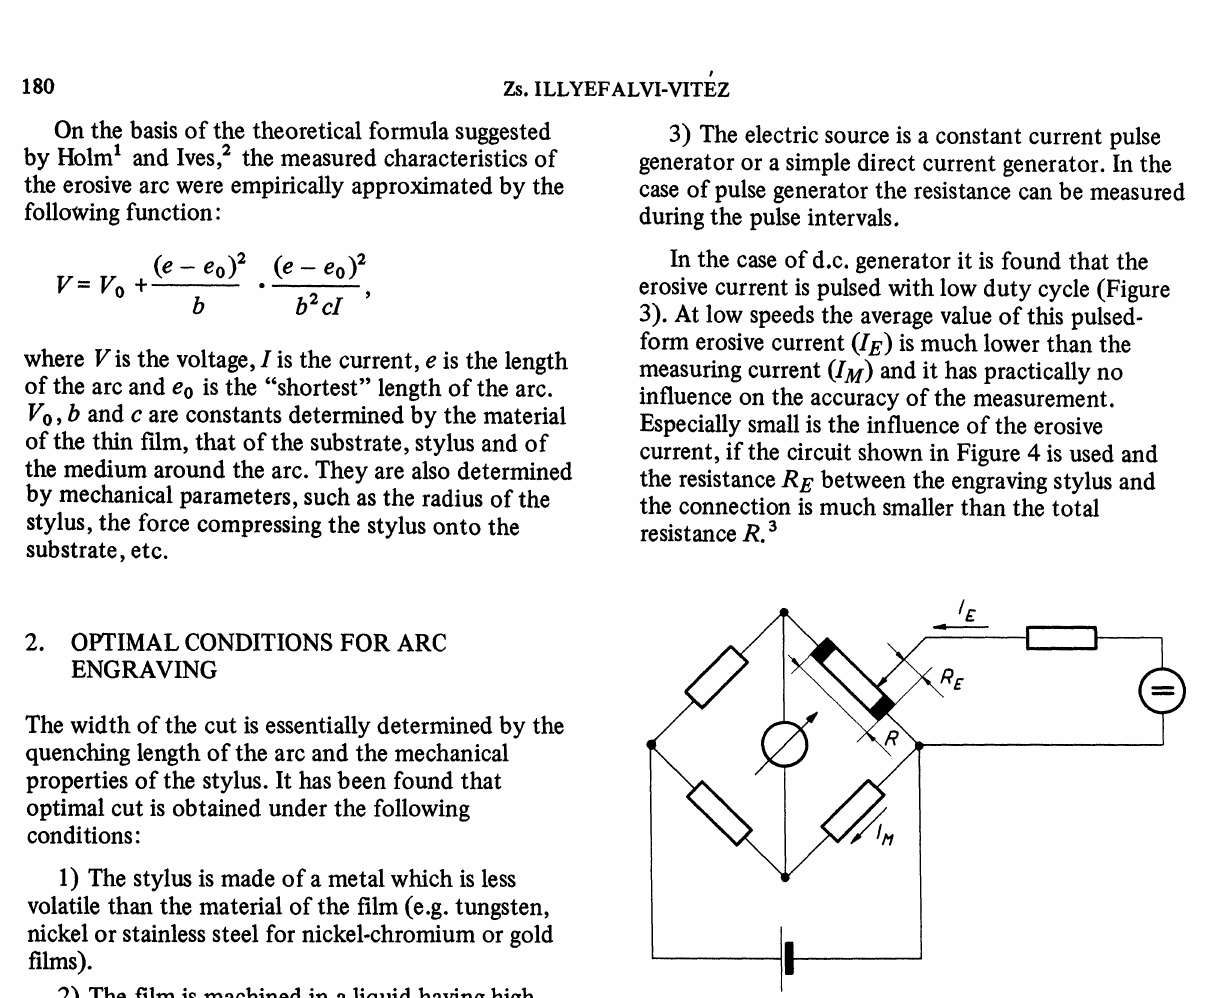
Circuit for active